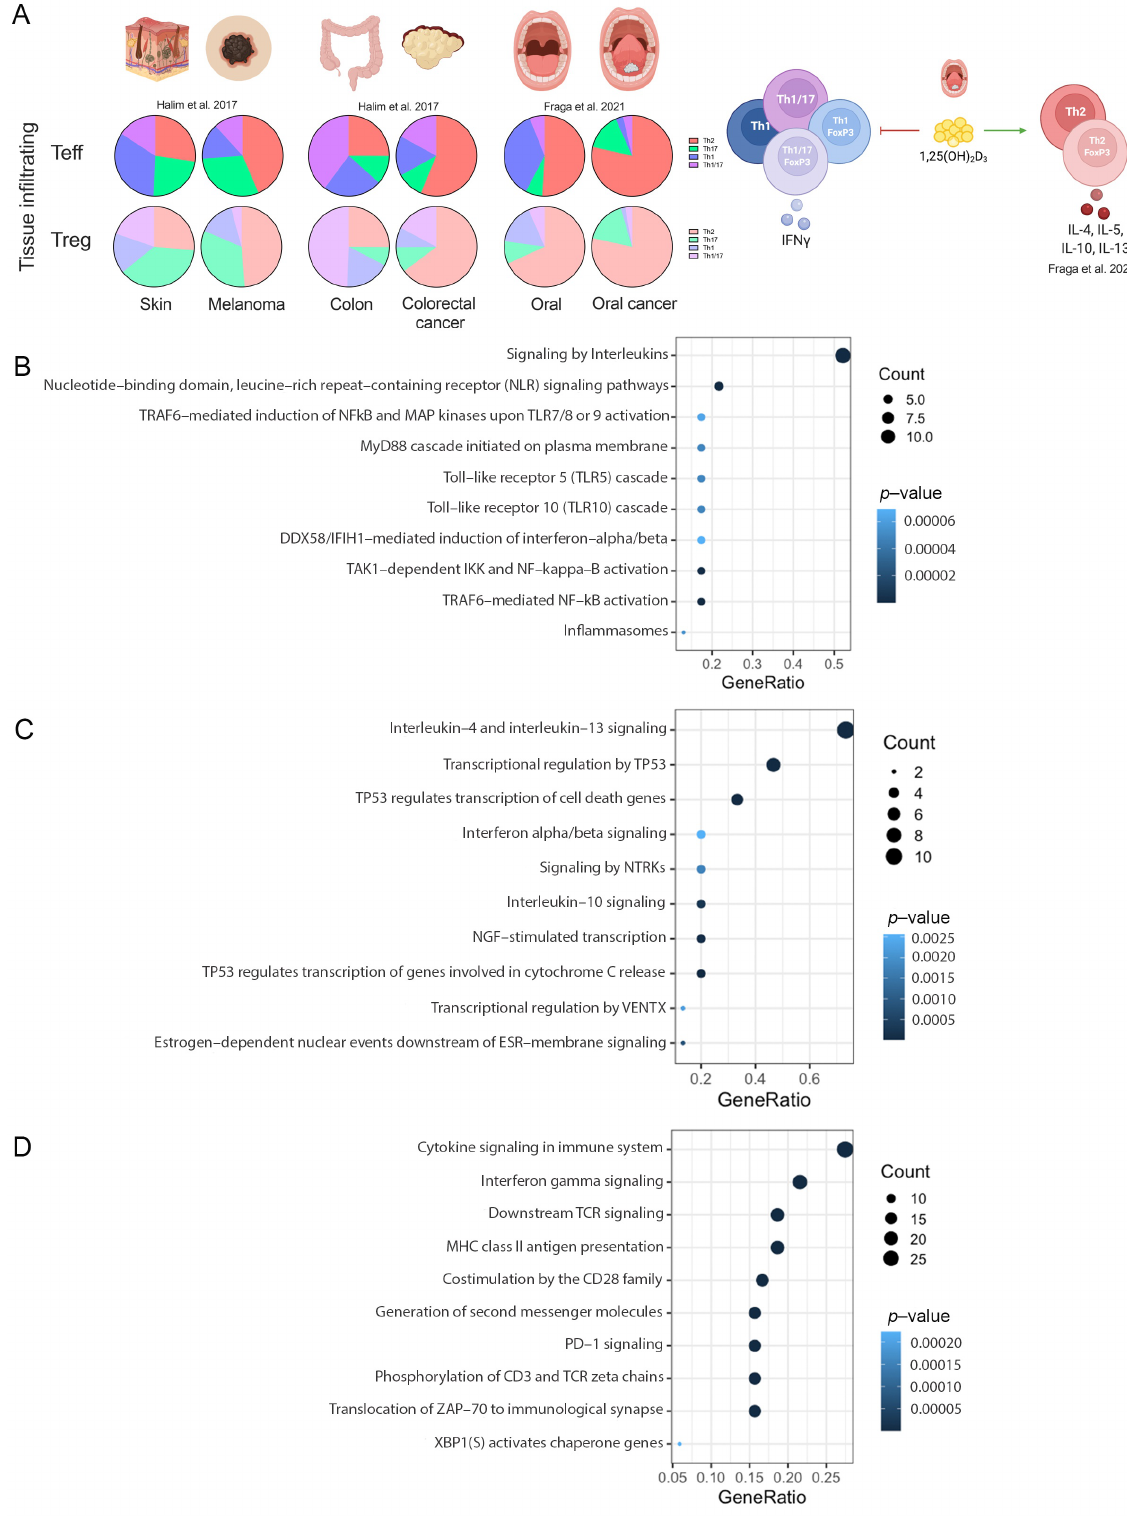
Figure 6. Pathways validation. ( A ) Summary of T-cells in melanoma, colorectal cancer and oral cancer from our lab [6,41]. Scatter plots of: ( B ) common pathways between CD4-T cells and RNA-seq experiments; ( C ) common pathways between Treg and RNA-seq experiments. ( D ) common pathways between CD4-T cells and proteomic